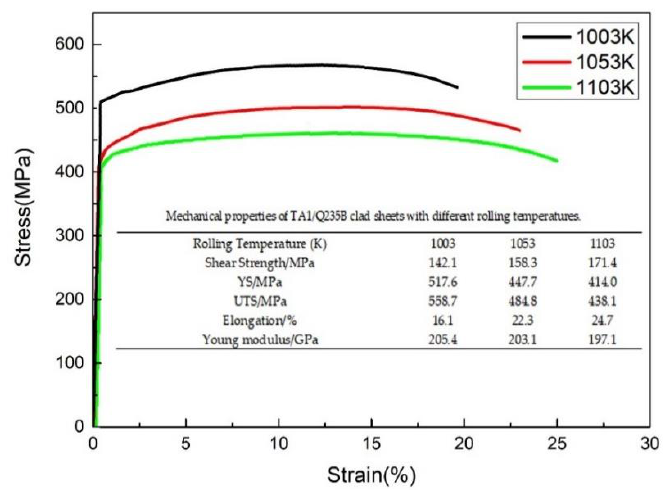
Figure 11. ( a ) Micrograph of microhardness test ( b ) schematic of microhardness test ( c ) microhardness of explosive welding plate and different temperatures rolled sheets. Figure 12. The tensile stress-strain curves and mechanical properties of TA1/Q235B composite sheets at different rolling temperatures. di ff erent rolling